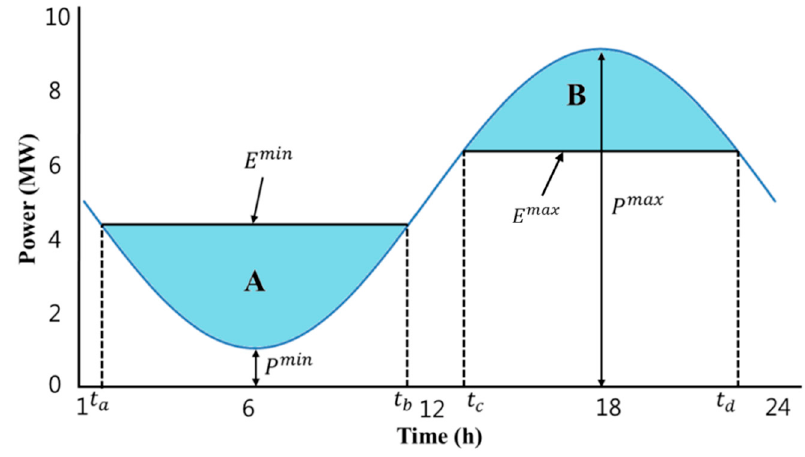
Figure 2. Charging/discharging strategy for the 24h load.